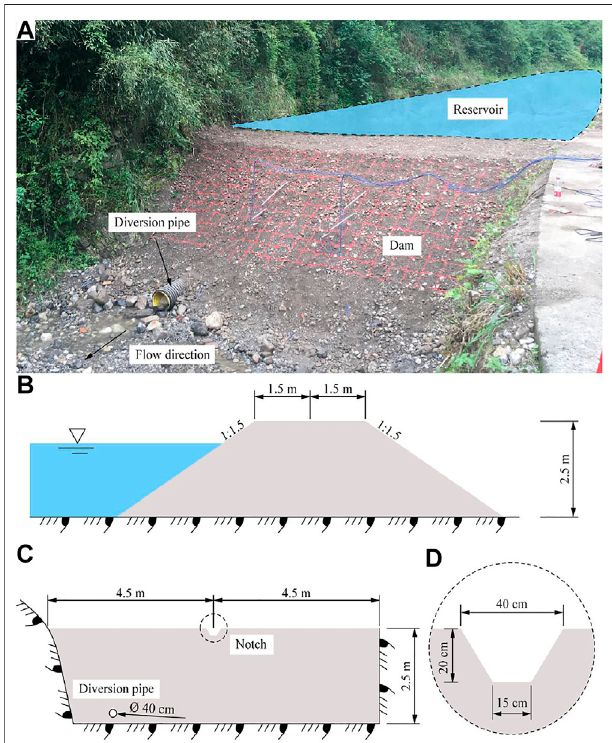
FIGURE 4 | Detailed dimensional sketches of the No. 3 model landslide dam: (A) the photo of the model landslide dam, (B) the cross pro fi le of the dam, (C) longitudinal pro fi le of the dam, and (D) dimension of notch on the model landslide.